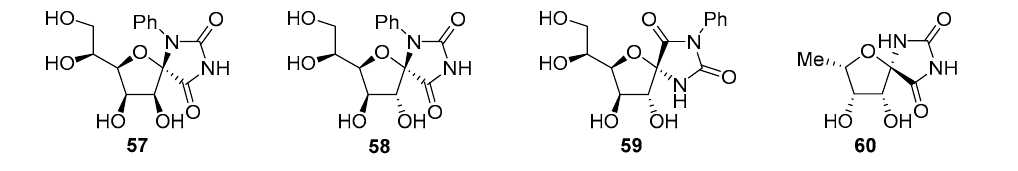
Figure 4. Hydantoins of pentoses and hexoses.